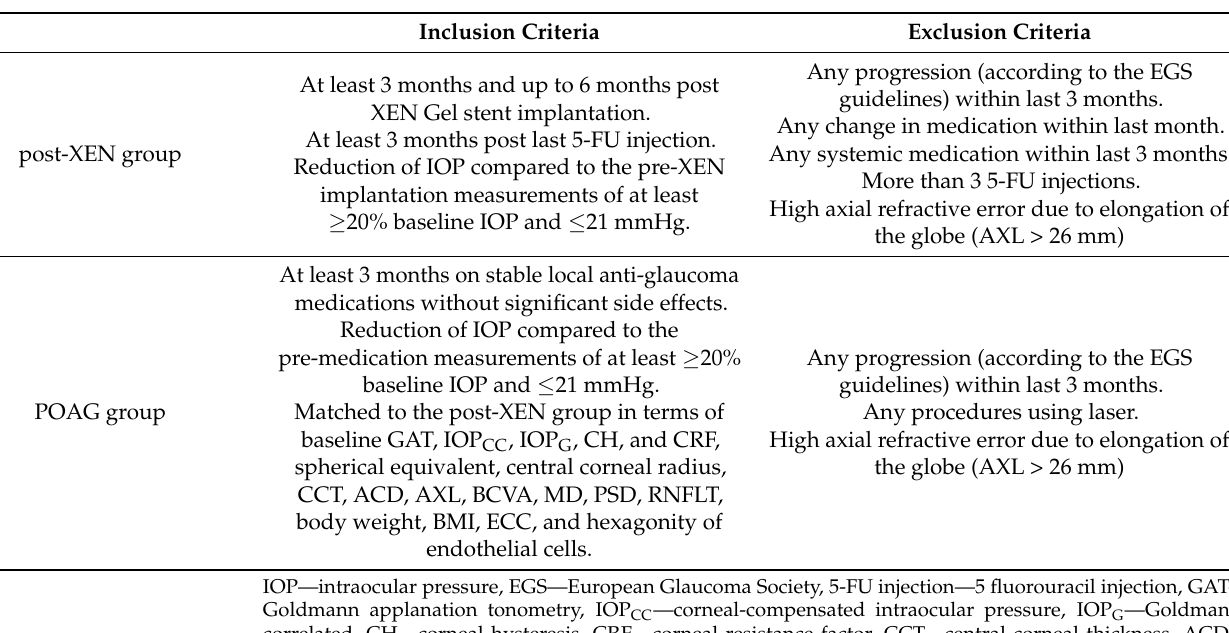
Table 1. Inclusion and exclusion criteria for post-XEN and POAG